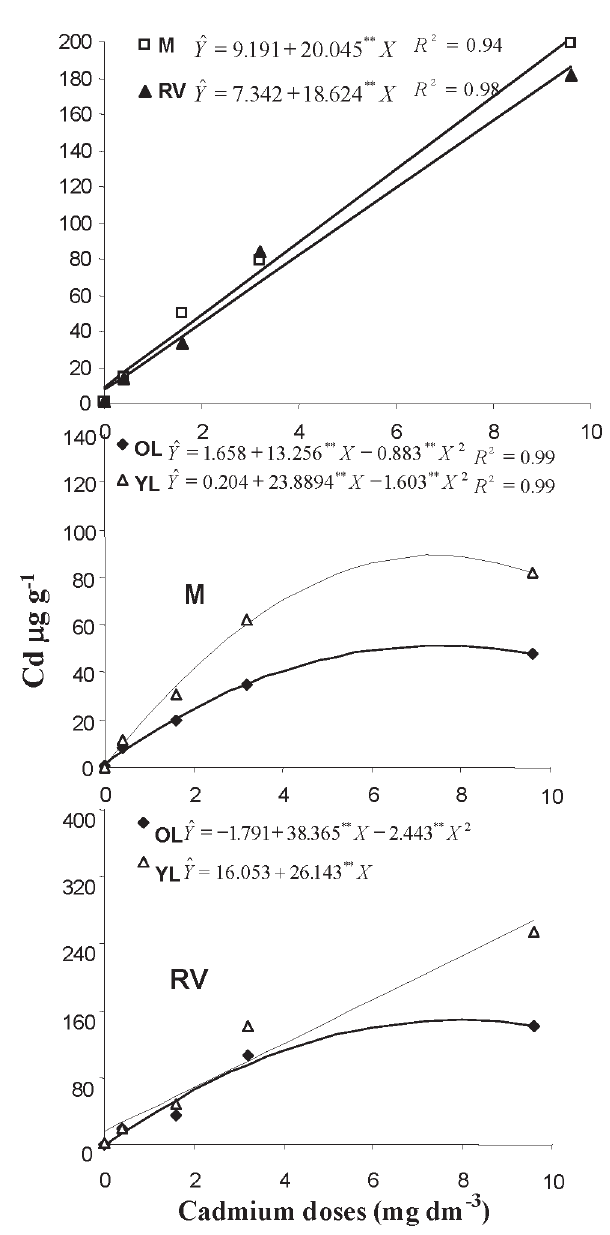
Figure 2 - Cadmium concentrations in roots of Mimosa-M and Regina Verao-RV cultivars and in young leaves-YL and old leaves-OL of Mimosa-M and Regina Verao-RV, as a result of Cd doses applied to soil (plants were grown for 44 days in the Cd amended